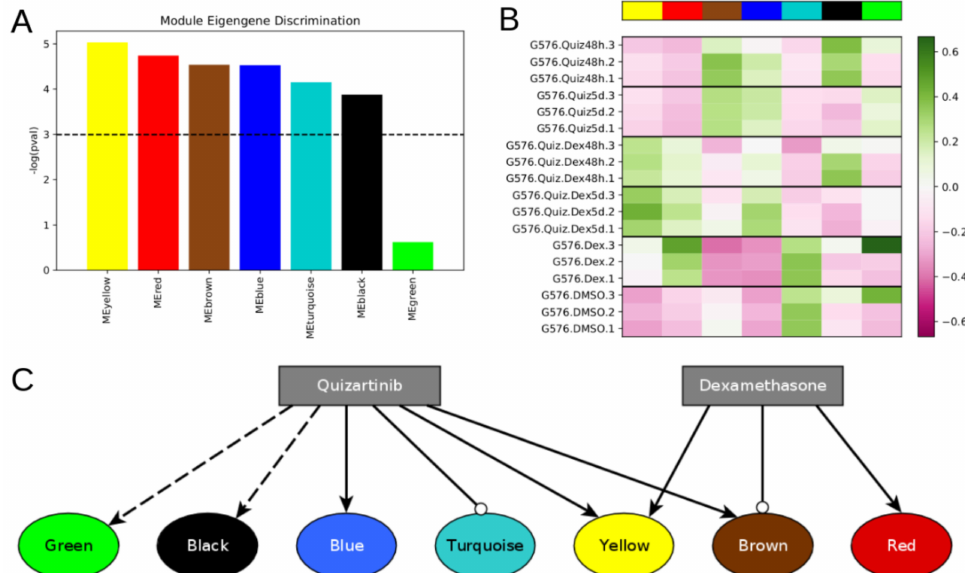
Figure 1. Differentially expressed modules respond differently to different treatment conditions. ( A ) WGCNA identified seven gene co-expression modules from the DMSO and drug treated FLT3 -ITD AML expression dataset, six of which are differentially expressed across the six different treatment conditions. ( B ) Heatmap showing module eigengene expression for each module in each sample. High module eigengene expression reflects high average expression of genes within that module. ( C ) Qualitative model showing the effect of each drug on the expression of genes within each module. Arrow-tipped edges indicate activation, while circle-tipped edges indicate repression. The dotted edge from quizartinib to the black module reflects the observation that black module genes are upregulated at 48 h by quizartinib, but become downregulated again by five days of treatment. The dotted edge from quizartinib to the green module reflects that the green module is not upregulated after 48 h, but is after 5